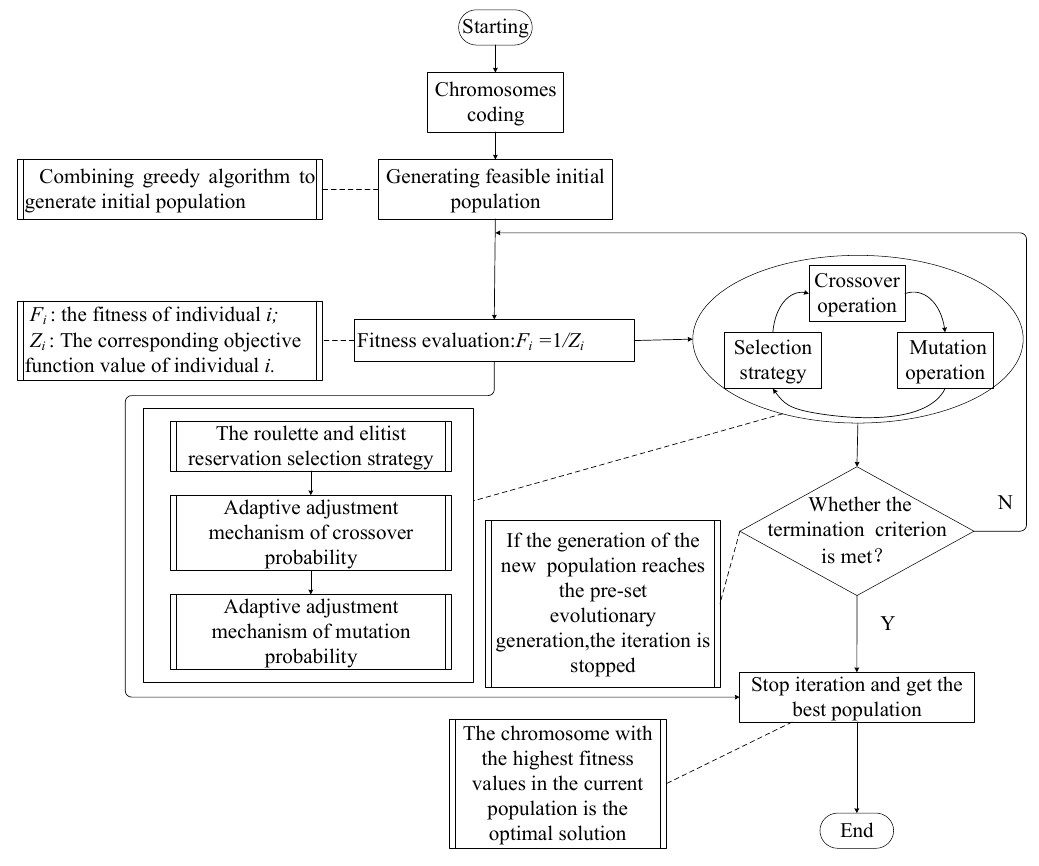
Figure 1. Basic process of hybrid genetic algorithm.